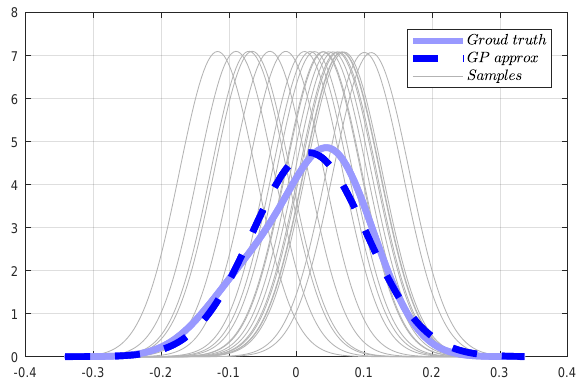
Figure 7. Graph interpretation of the Monte Carlo sampling. Note that the true distribution is not a GP as given with a dashed blue line, and it is evaluated as a GP shown in the solid blue line with 20